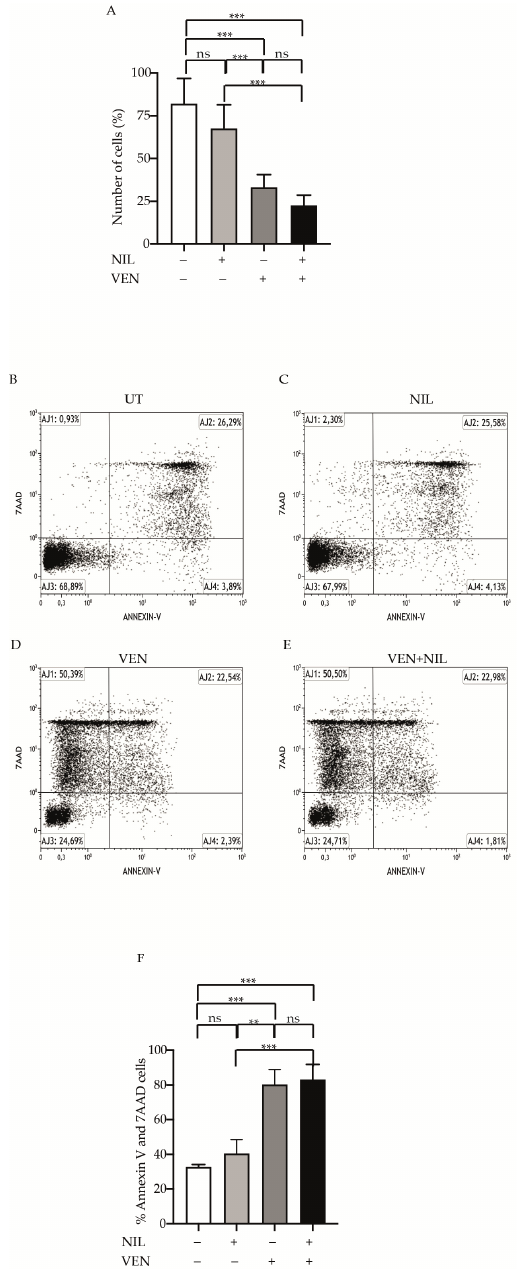
Figure 5. Anti-proliferative and pro-apoptotic activity of BCL2 and BCR-ABL1 co-inhibition in Ph+ lymphoblastic B-ALL cells. ( A ). Peripheral B-ALL cells derived from B-ALL patients ( n = 3) at diagnosis were exposed for 24 h to the indicated drugs (Venetoclax 400 nM, Nilotinib 2 µM). Histograms report the viability cells obtained setting arbitrary at 100% the number of cells implanted at the start of the experiment. ( B – E ) Representative experiment of peripheral B-ALL cells untreated ( B ) or treated with Nilotinib ( C ), Venetoclax ( D ) or their combination ( D ). After 24 h cells were collected and stained with Annexin V/7-AAD. Scatter plots indicate the unstained (AJ3), Annexin V (AJ4), Annexin V/7-AAD (AJ2) or 7-AAD (AJ1) stained cells ( n = 2). F Histograms report the average percentage of Annexin and 7-AAD cells obtained from B-ALL patients. Bars indicate the standard deviation resulting from the average of two patients. Statistical significance was calculated by analysis of variance (ANOVA) plus Bonferroni’s posttests ( p < 0.05 *, p < 0.01 **, p < 0.001 ***). UT:Untreated, NIL:Nilotinib, Ven: Venetoclax.